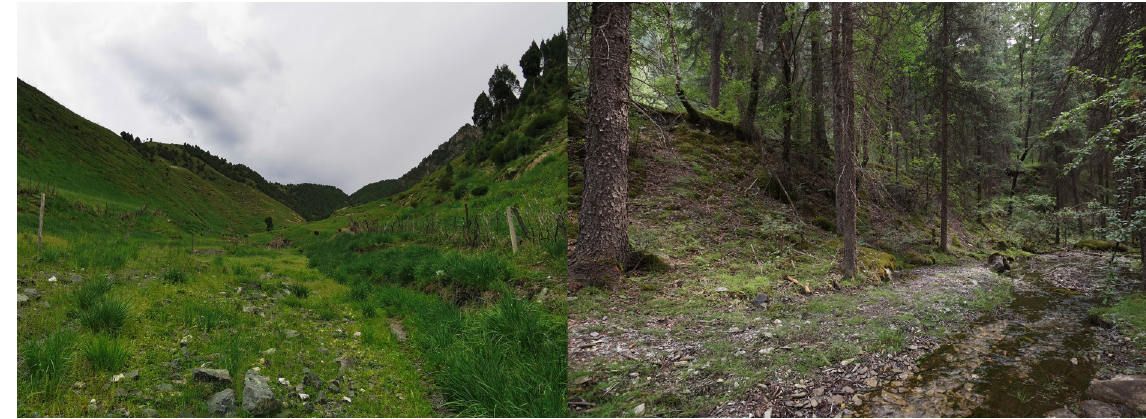
Fig. 42. The ecological environment of Biema qilianensis Huo & Liu gen. et sp. nov. collection area in